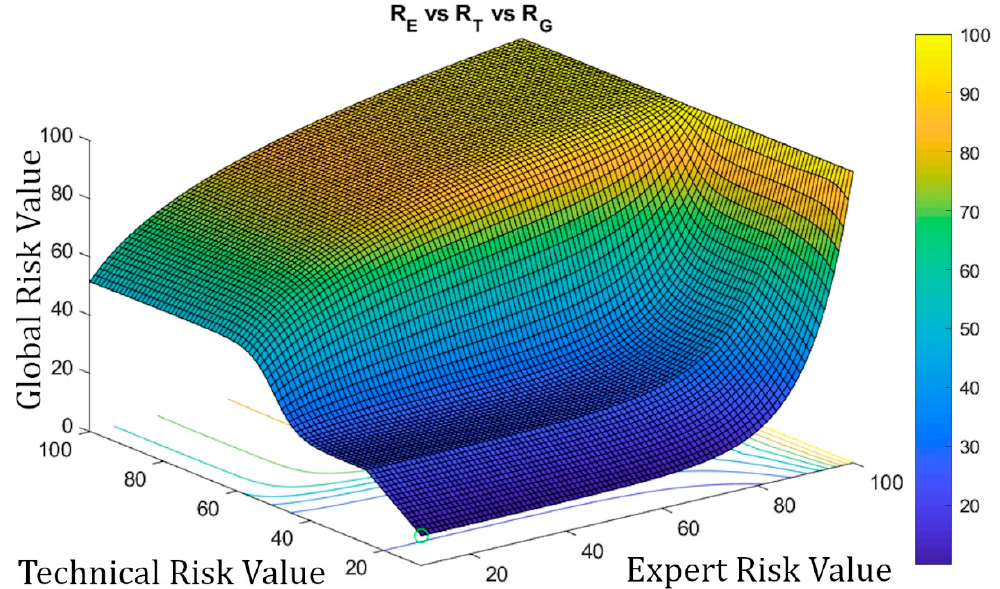
Figure 16. Technical Risk vs. Expert Risk vs. Corrected Global Risk.